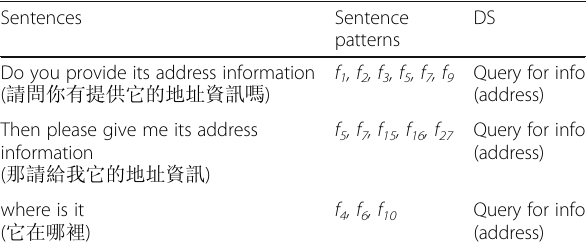
Table 3 Examples of sentence patterns